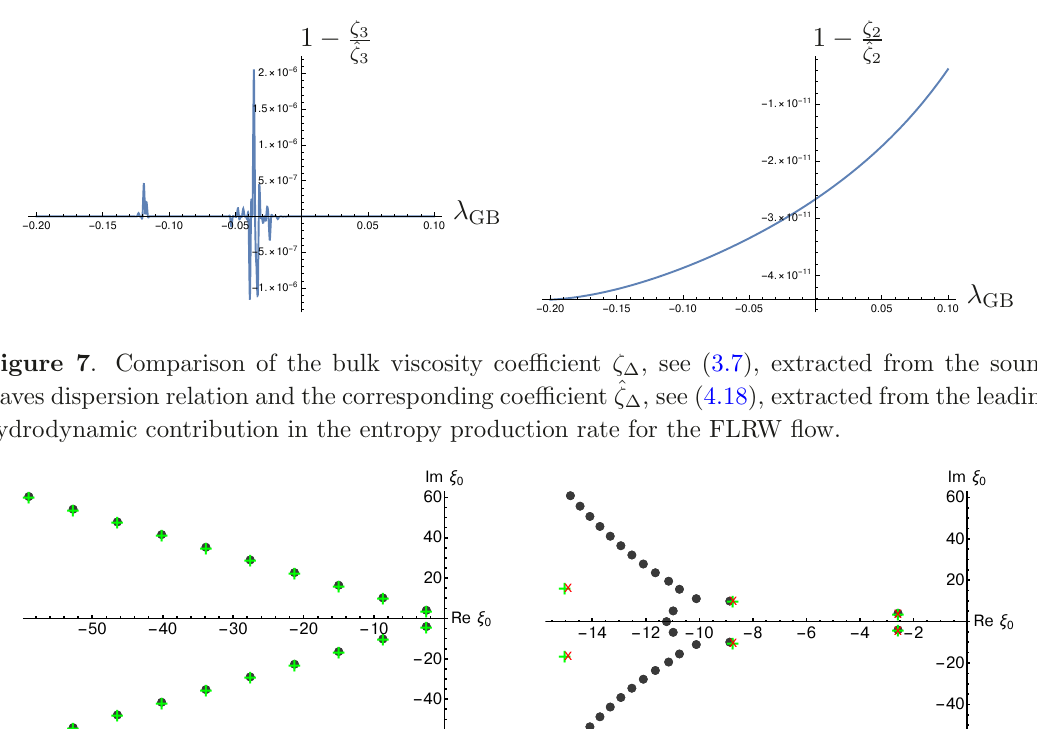
0 . 001001) (right panel). We used n max = 300 −